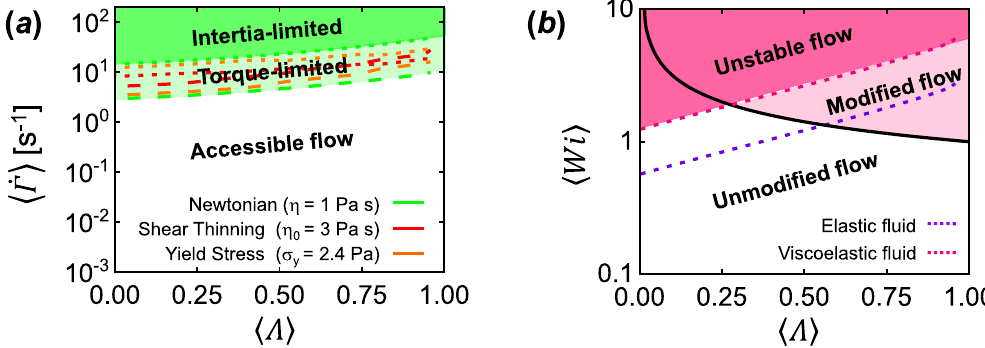
Figure 8. Operating diagrams indicating accessible flows in the FFoRM. ( a ) Operational limits for average flow type ( Λ ) and magnitude of velocity gradient tensor ( 〈 Γ  〉 ) for inelastic fluids tested in the FFoRM under strong flow conditions ( Λ > 0). Practical limitations due to inertia (dotted lines) or the pump torque (dashed lines) define an upper limit on 〈 Γ  〉 for a given Λ in the current setup for the fluids indicated (colored lines). ( b ) Limits for Λ and 〈 Wi 〉 for elastic and viscoelastic fluids tested in the FFoRM. Practical limitations due to inertia (dotted lines) or physical limitations due to the fluid elasticity (solid black line) define the upper limit of 〈 Wi 〉 for a given Λ , defining regions of modified (steady) and unstable (unsteady)